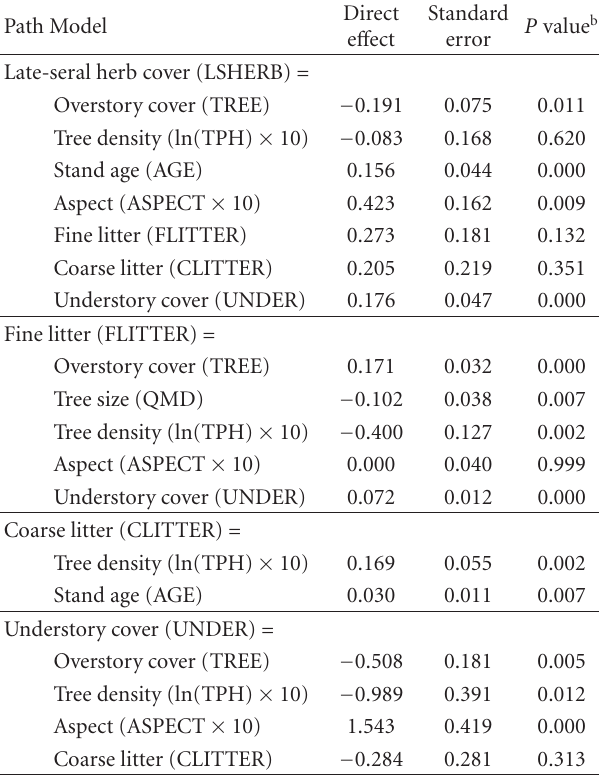
Table 4: Estimated combined indirect e ff ects (i.e., all possible indirect paths) on the endogenous latent variables in the overstory- understory SR model, along with corresponding standard errors and P